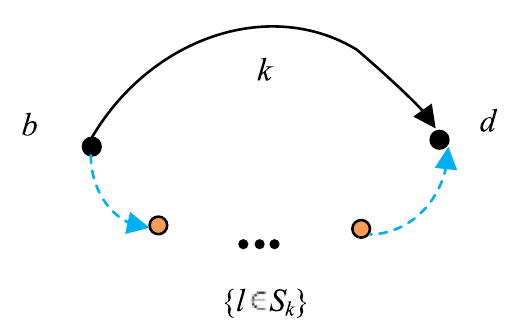
Fig. 6 A path connecting two neighboring